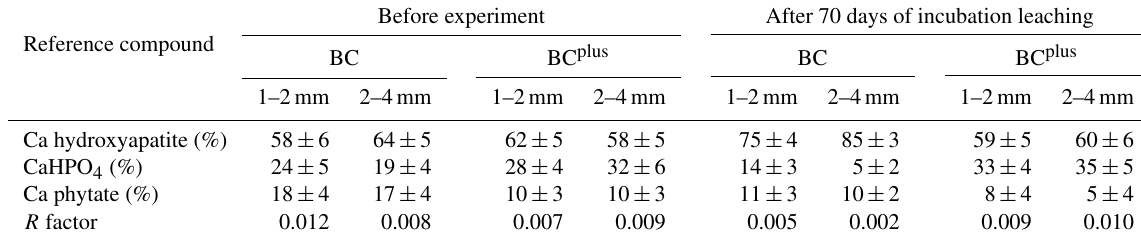
Table 2. Results of linear combination fitting (LCF) conducted on P K -edge XANES spectra of bone char (BC) and surface-modified bone char (BC plus ) particles before and after a 70-day incubation-leaching period. These best fits were achieved using all possible combinations with 19 spectra of P reference compounds.